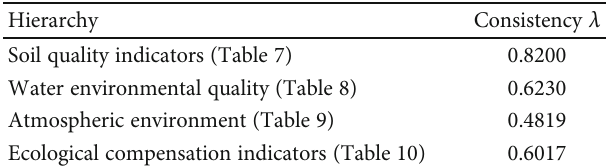
Table 12: The consistency of each fuzzy comparison